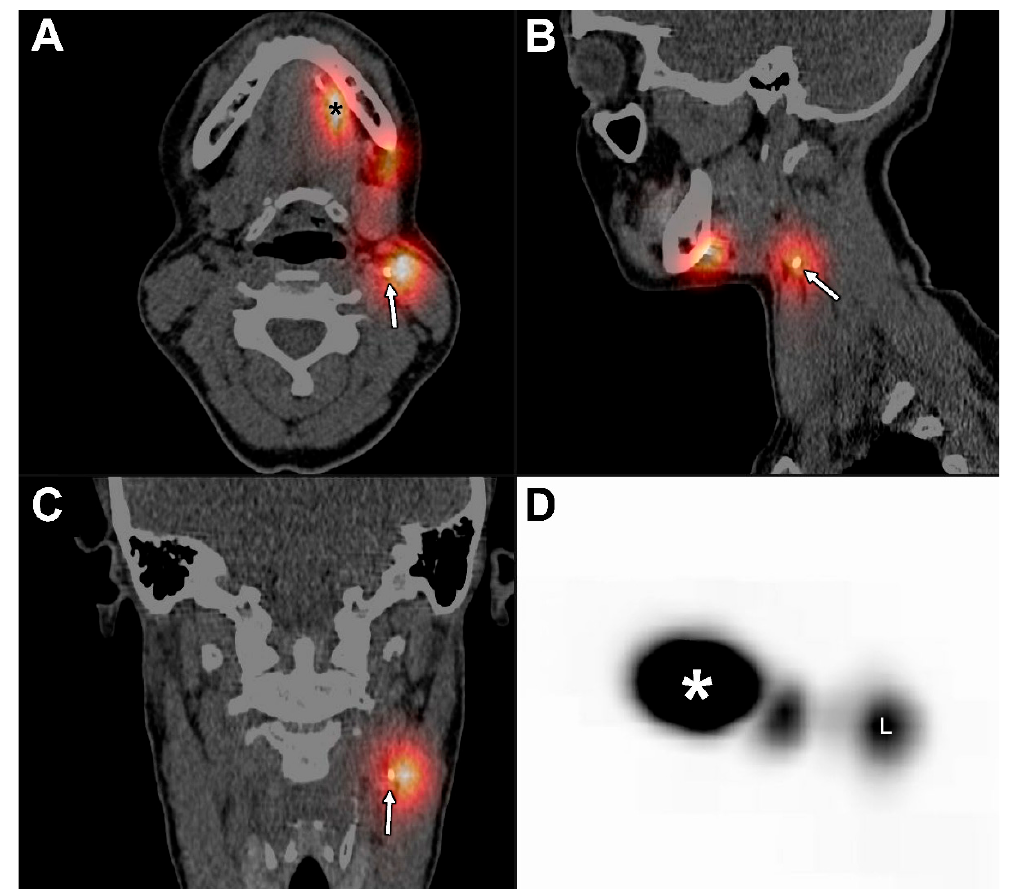
Figure 4. Fusion of SPECT and late CTL at 120 min post-injection of Lipiodol ® in the same patient (patient 6). ( A ) Axial plane, ( B ) sagittal plane, ( C ) coronal plane, and ( D ) maximum intensity projection (MIP); (*) injection site. The presence of Lipiodol ® was seen in a SLN located in cervical lymph node level IIa on the left side (white arrows), as identified with SPECT, corresponding with the hotspot (L) on MIP. Conventional 99m Tc-nanocolloid lymphoscintigraphy (including SPECT/CT) identified another SLN in cervical lymph node level Ib on the left side, in which no uptake of Lipiodol ® could be seen on late CTL.